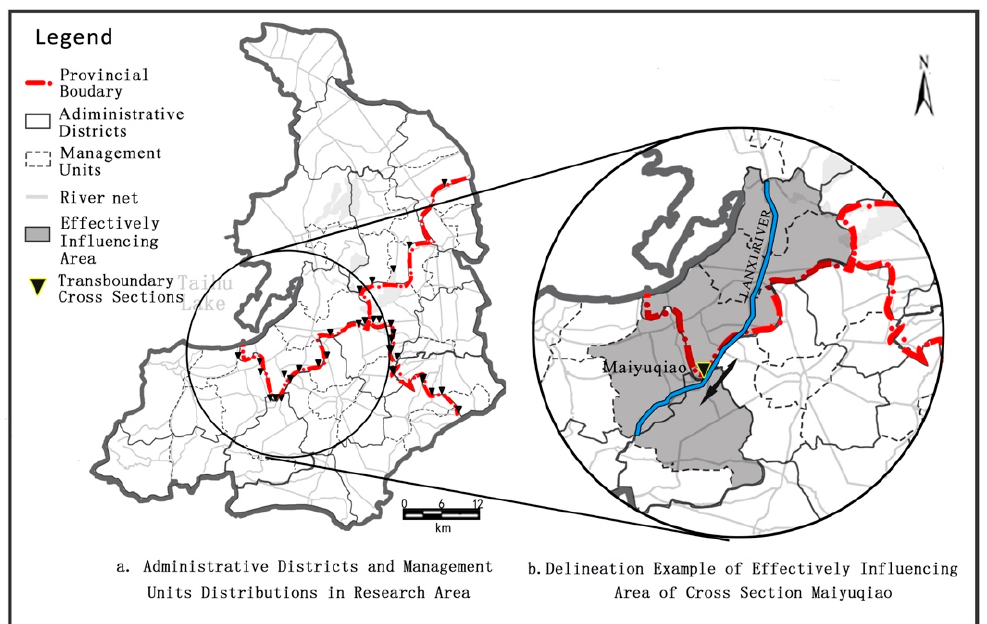
Figure 5. Example of trans-boundary effectively influencing area of trans-boundary cross section.